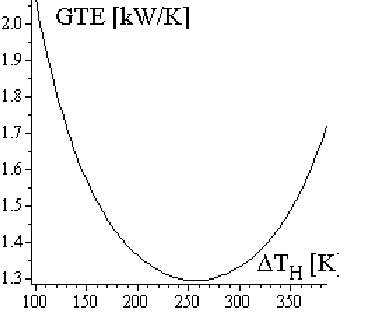
TEmin = 1.295 for Δ T H = 257 K.